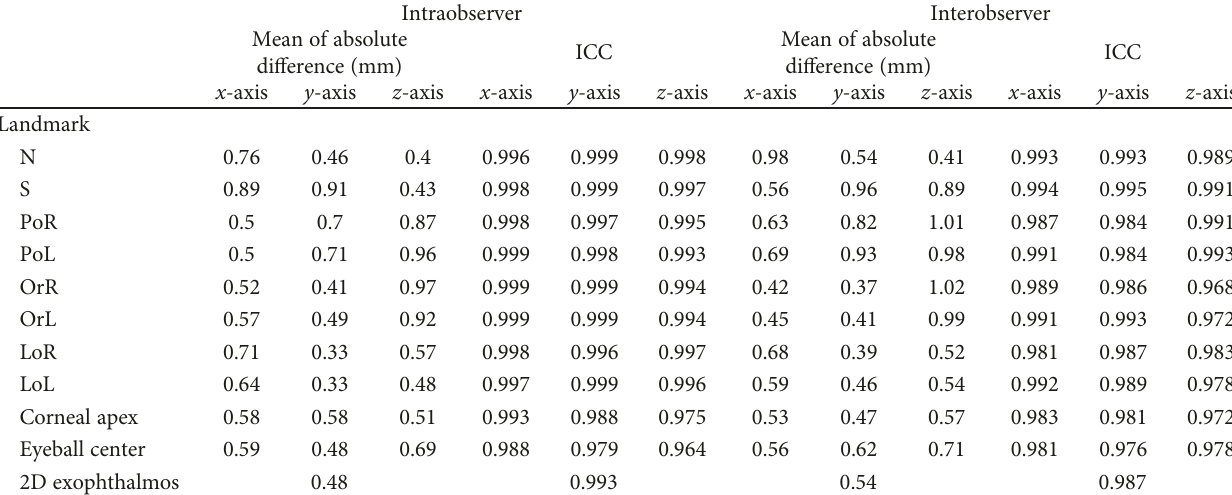
Table 3: The reliability analysis of CT